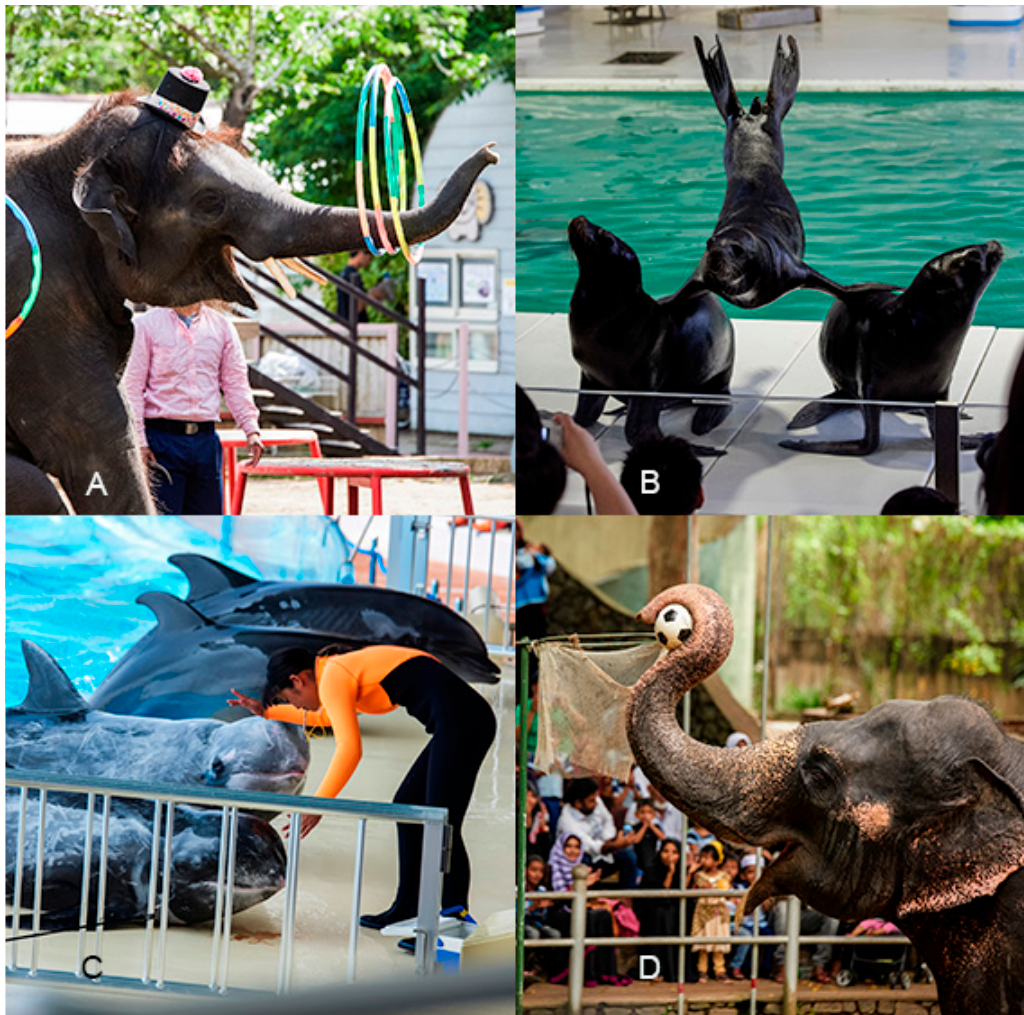
Figure 9. Example images for the four AVIs advertised that appear to be in contravention of WAZA’s animal welfare strategy. ( A ) An Asian elephant ( Elephas maximus ) in a top hat spinning “hoola” hoops for a show; ( B ) sea lions ( Zalophus californianus ) perform a “hand stand pyramid” for a show; ( C ) Dolphins (Delphinoidea spp.) beached for a show; and ( D ) an Asian elephant plays basketball for a show. Images were taken from screenshots of our data set included in this study. Images A, B, C and D were taken by a field researcher during visits to facilities (copyright Fernando Carniel Machado). Images A, C and D were taken at facilities that fall under the category of WAZA regional associate members. Image D was taken at a facility that falls under the category of being a direct member of WAZA. Images have been altered to ensure any individuals are made anonymous and are representative of screen shots included in the data set of this study.